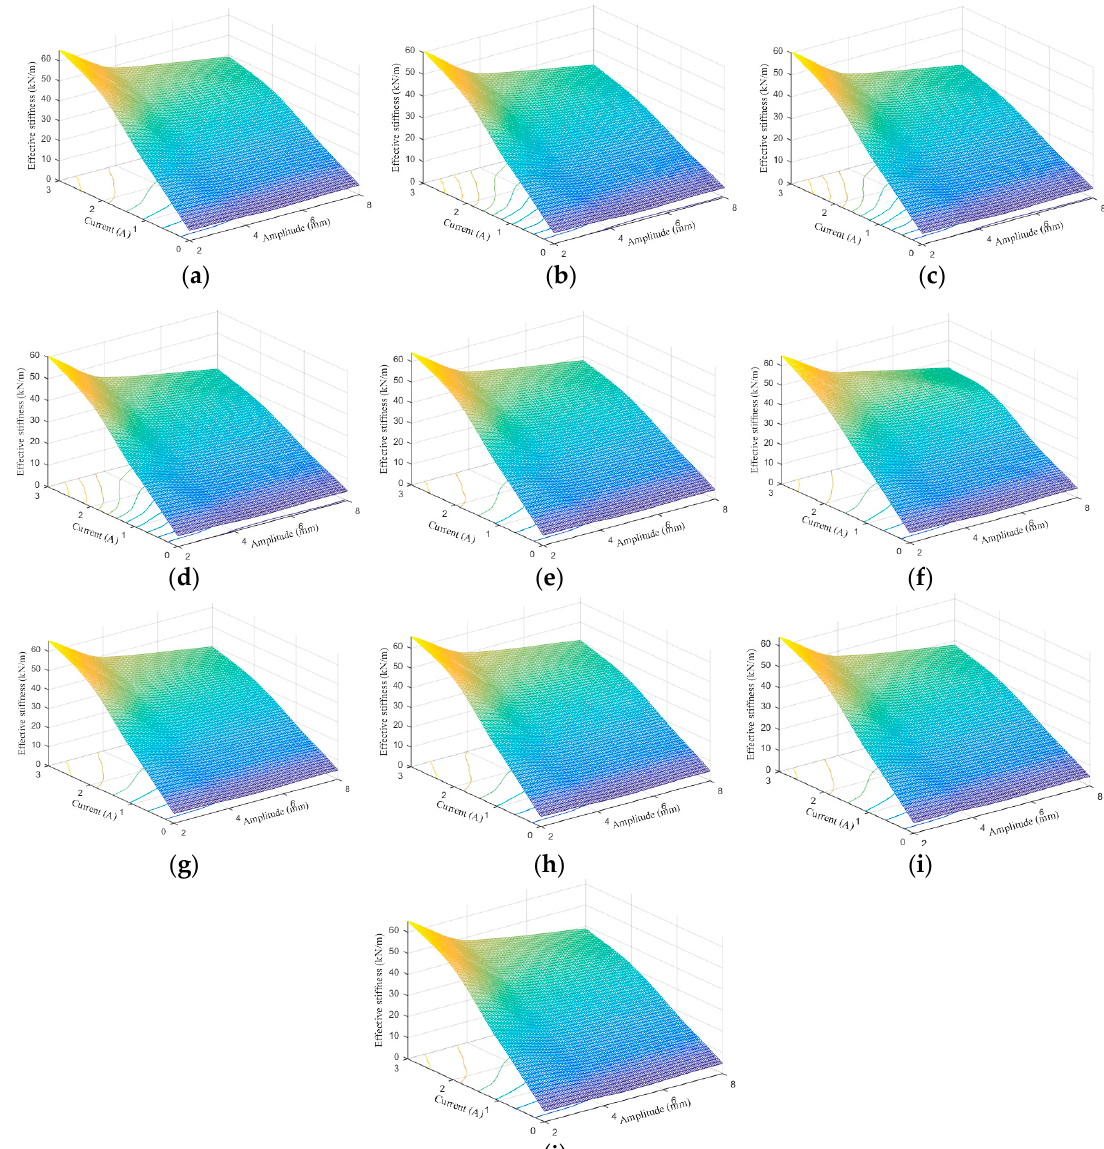
Figure 24. Effective stiffness estimation results of 0.1 Hz loading frequency. ( a ) Experimental measurement, ( b ) Kelvin–Voigt model, ( c ) four-parameter viscoelastic model, ( d ) rheological model, ( e ) BW model, ( f ) improved BW model, ( g ) Dahl model, ( h ) improved LuGre friction model, ( i ) strain stiffening model, and ( j ) hyperbolic hysteresis model.